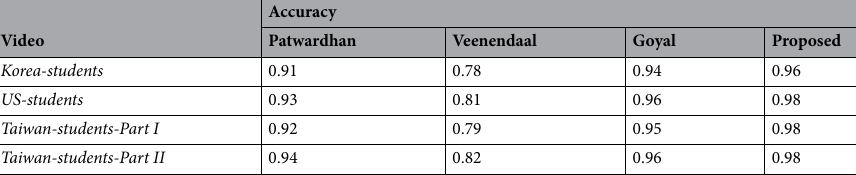
Table 6. Compare the proposed scheme with Patwardhan, Veenendaal, and Goyal using accuracy videos for Korean-students , US-students , and Taiwan-students .